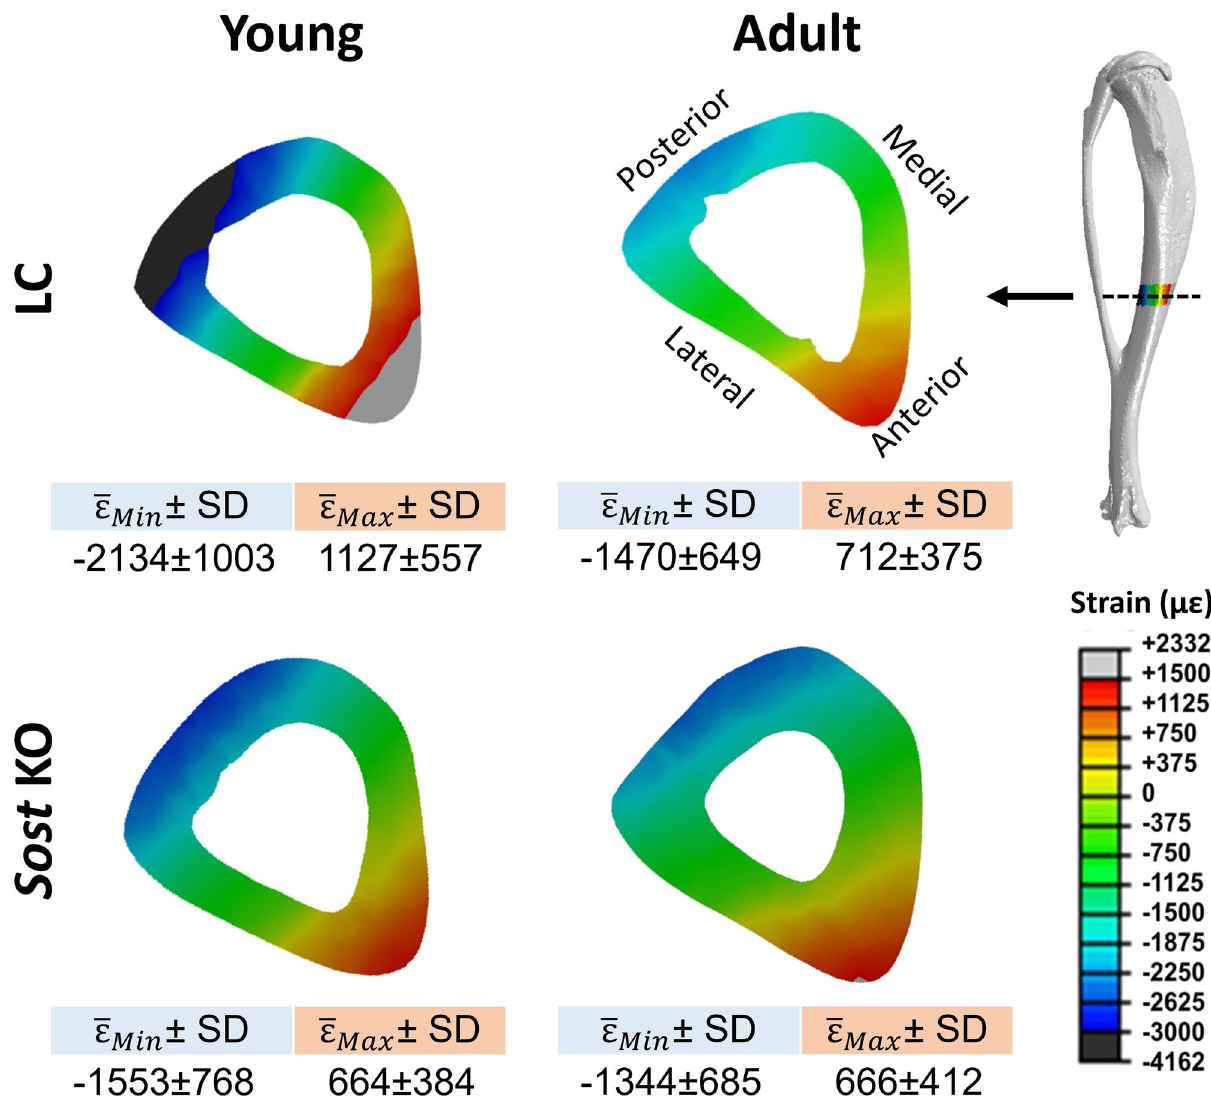
Figure 2. In vivo load-induced strain distribution in the midshaft cortical bone of the tibiae of young (10-week- old) and adult (26-week-old) littermate control (LC) and Sost knockout (KO) male mice. Red and blue indicate tension and compression,